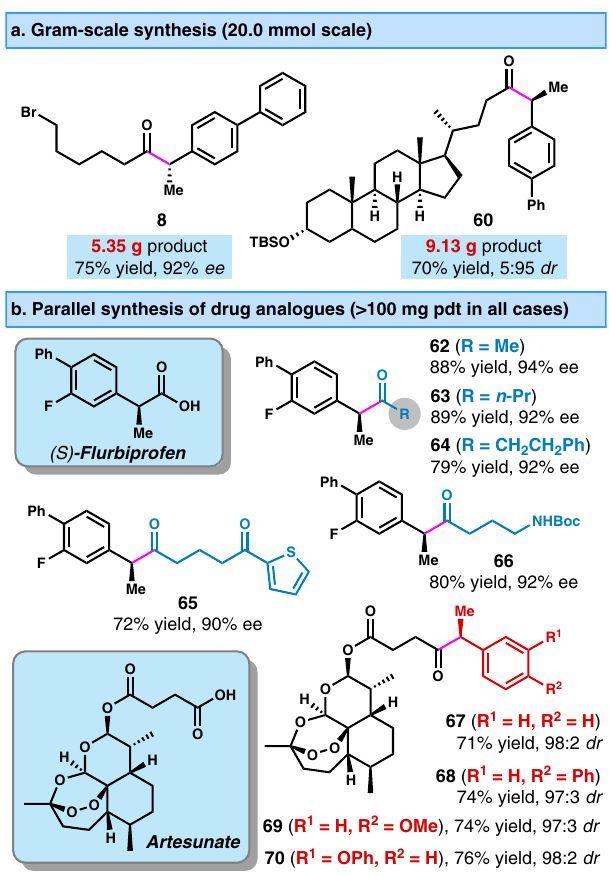
Fig. 4 Gram-scale synthesis and parallel synthesis. a Gram-scale synthesis. b Parallel synthesis of drug